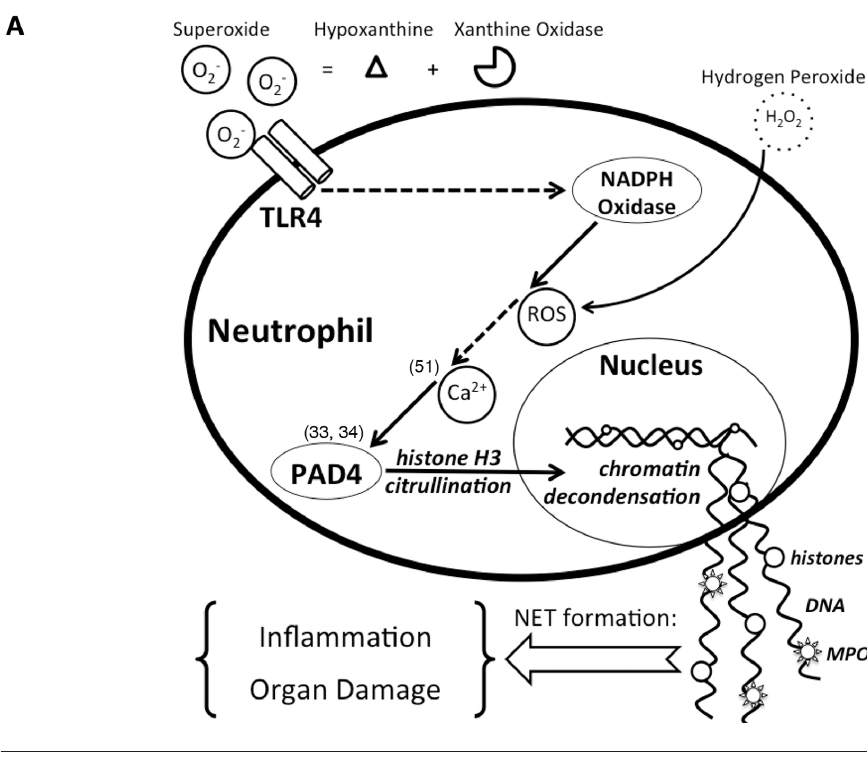
figure 5. Proposed model of NET induction by extracellular superoxide. (A) Schematic representation of superoxide (O 2- ) generation during and elements of the NET-promoting cascade. During liver I/R, membrane-nonpermeable superoxide functions to activate TLR-4 signaling pathways, which subsequently activates NOX, leading to induction of NETs. Membrane-permeable hydrogen peroxide (H without activation of